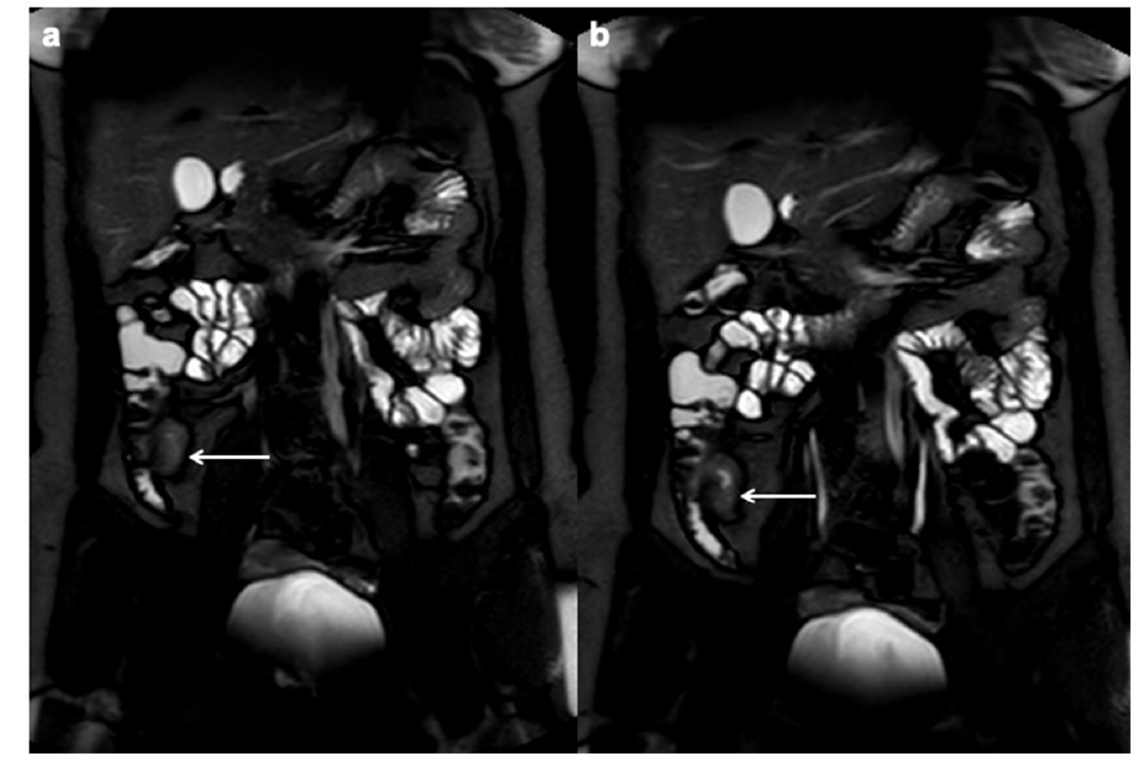
Figure 3. Intramural edema. Coronal T2 FSE with FS MRE images ( a , b ) in a patient with CD detect wall thickening in the distal ileum, with increased mural signal intensity (white arrows), finding consistent with edema.